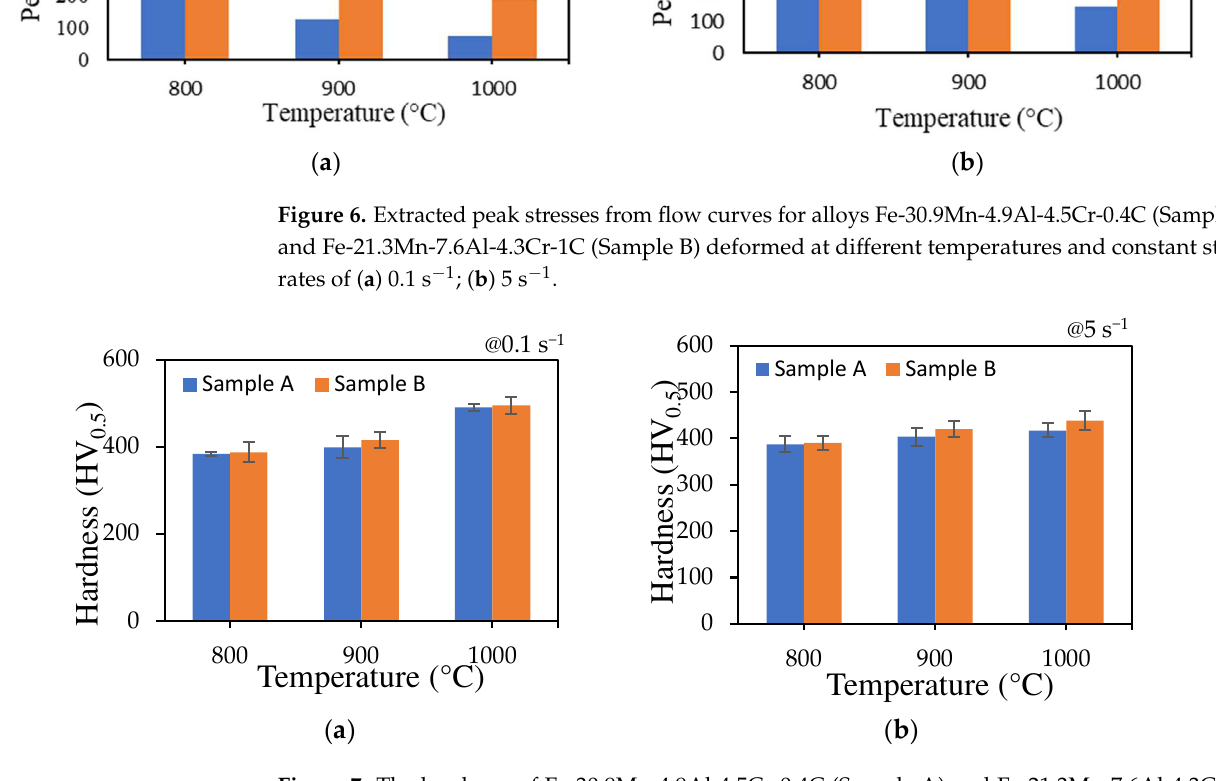
Figure 7. The hardness of Fe-30.9Mn-4.9Al-4.5Cr-0.4C (Sample A) and Fe-21.3Mn-7.6Al-4.3Cr-1C (Sample B) deformed at different temperatures and constant strain rates of ( a ) 0.1 s −1 ; ( b ) 5 s −1 .